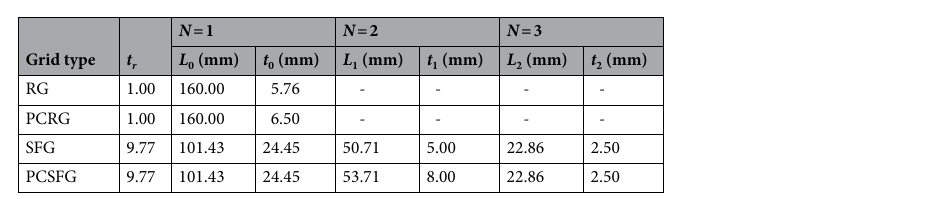
Table 1. Parameters of the grids in Fig.